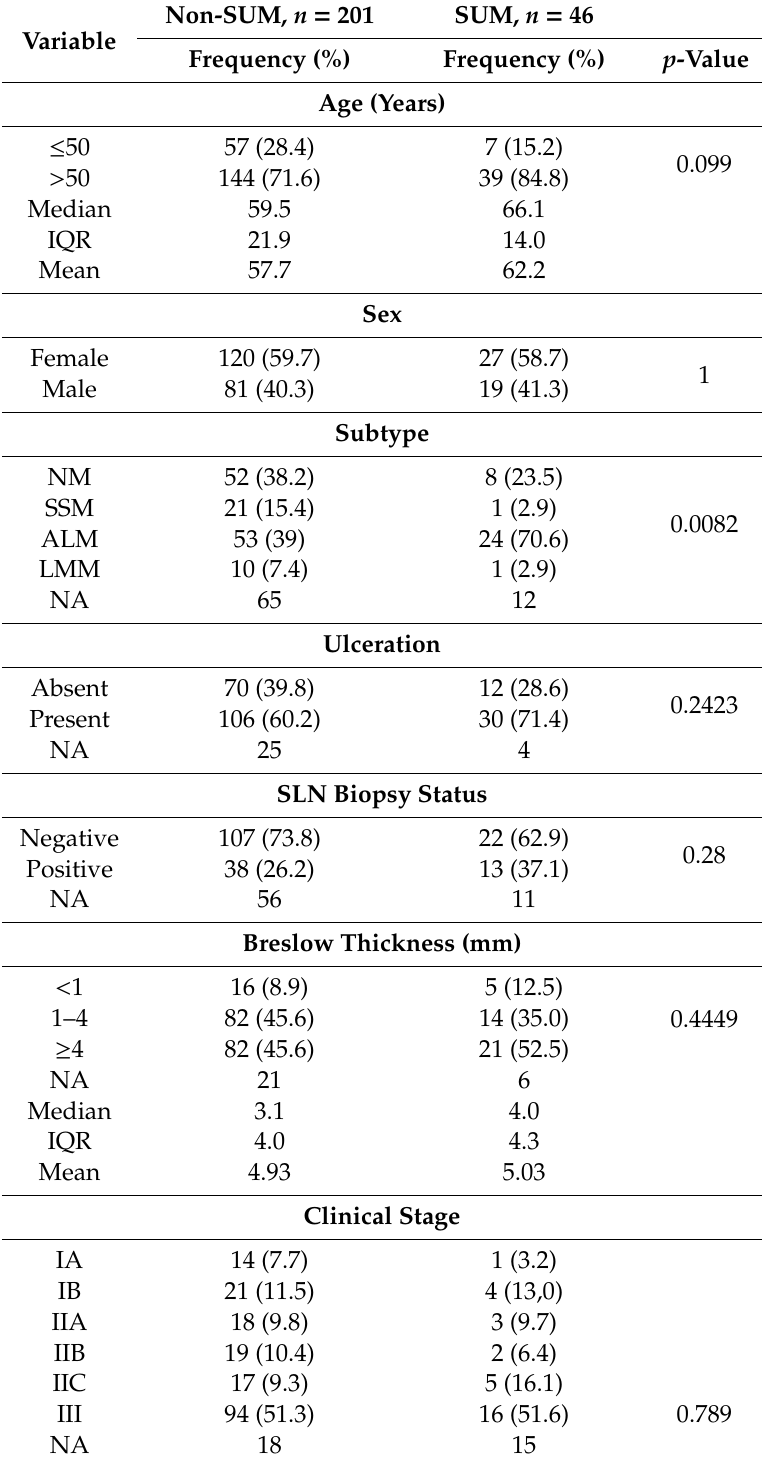
Table 2. Clinicopathological features of non-SUM vs. SUM